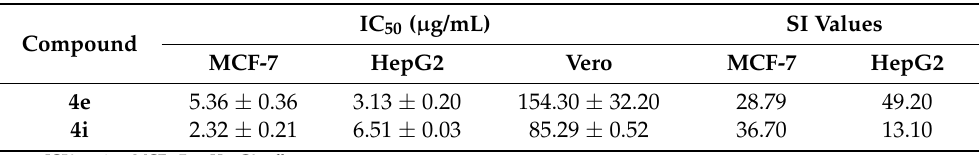
Table 2. The cytotoxic activities of compounds 4e and 4i on MCF-7, HepG2, and Vero cell lines and the calculated selectivity indices.